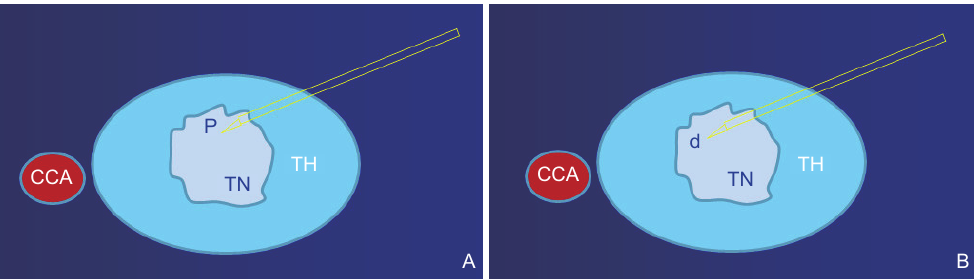
Figure 17 Mode of fast-trembling puncture needle within a small range. (A) Diagram of the proximal puncture point of the target nodule (p-proximal point, TN-thyroid nodule, TH-thyroid, CCA-common carotid artery); (B) Diagram of the distal puncture point of the target nodule (d-distal